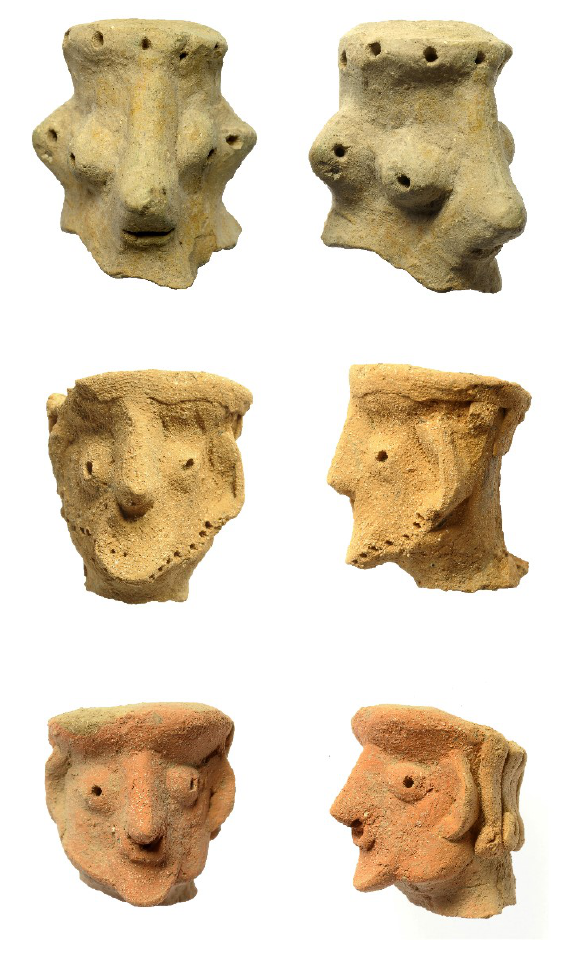
Figure 4 Clay heads from Khirbet Qeiyafa (above) and Tel Moza (middle and below) (Iron Age